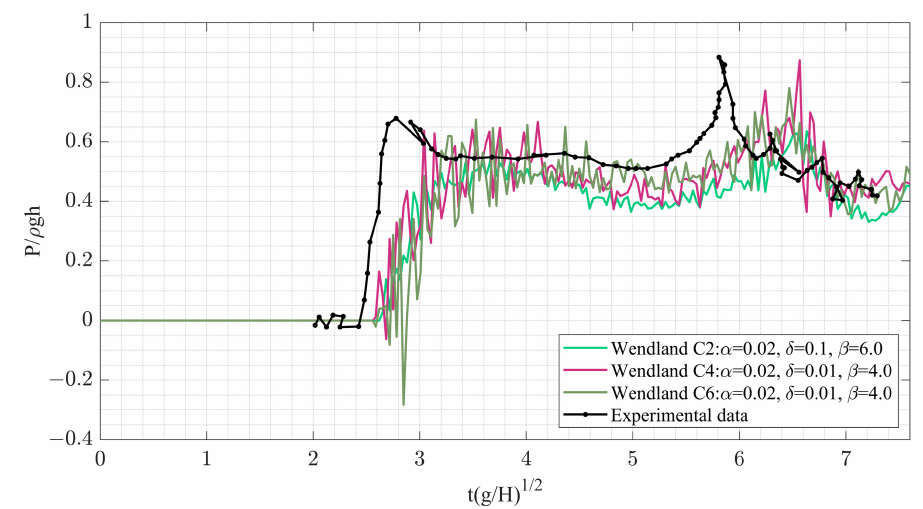
Figure 5. Comparison of the interpolated pressure data at the measurement location against the experimental measurements for the chosen numerical scheme for different Wendland